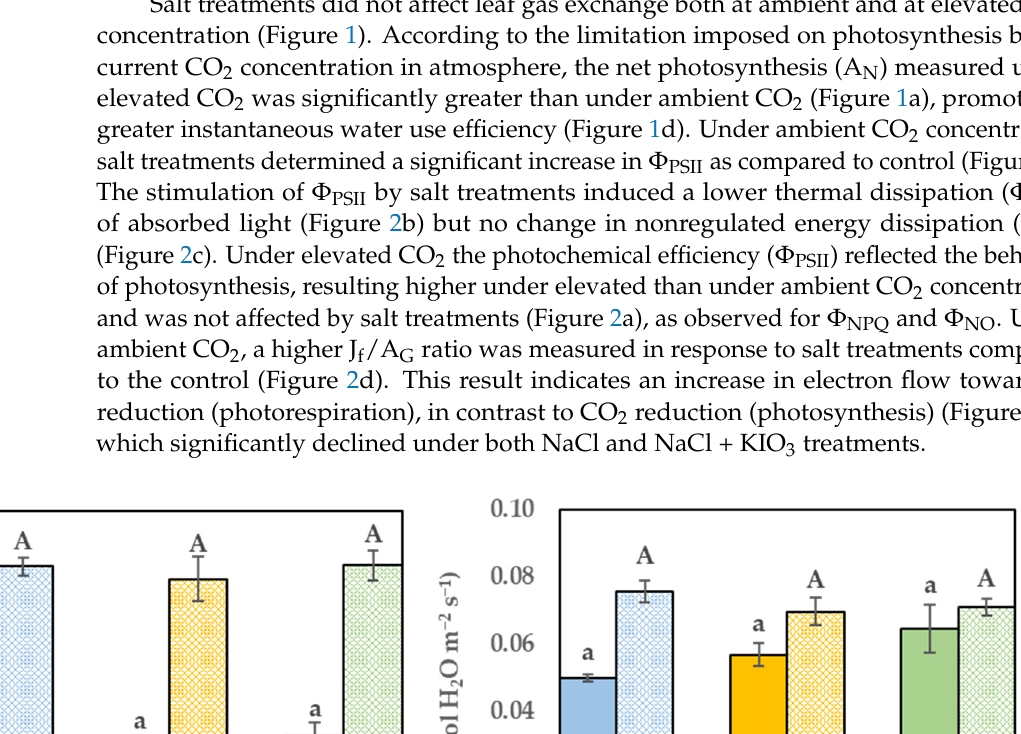
Figure 1. ( a ) Net photosynthesis (A N ); ( b ) stomatal conductance (G s ); ( c ) intercellular to ambient CO 2 concentration ratio (C i /C a ); ( d ) instantaneous water use efficiency (WUE) measured in plants ferti- lized with nutrient solution (C), in plants fertilized with nutrient solution plus salt (NaCl), and in plants fertilized with nutrient solution plus salt and iodine (NaCl + KIO 3 ). Filled bars: measurements to ambient CO 2 ; cross-linked bars: measurements to elevated CO 2 . Data are means ± SE. Different letters indicate statistical difference among treatments ( p < 0.05).